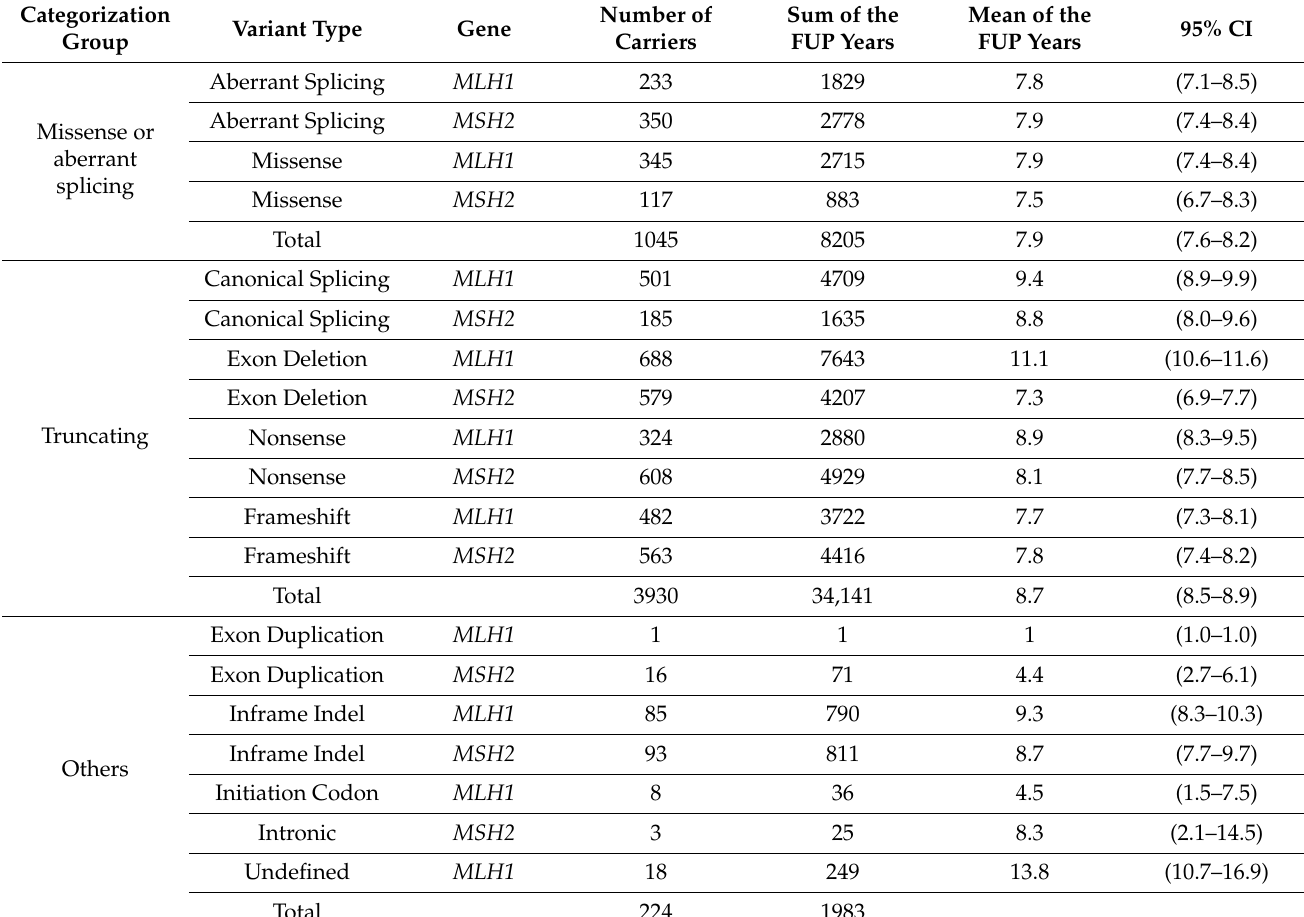
Table 1. Categorization of the path_MLH1 and path_MSH2 carriers having inherited variants causing truncating or mis- sense/aberrant splicing clinically actionable variants as defined in the InSiGHT